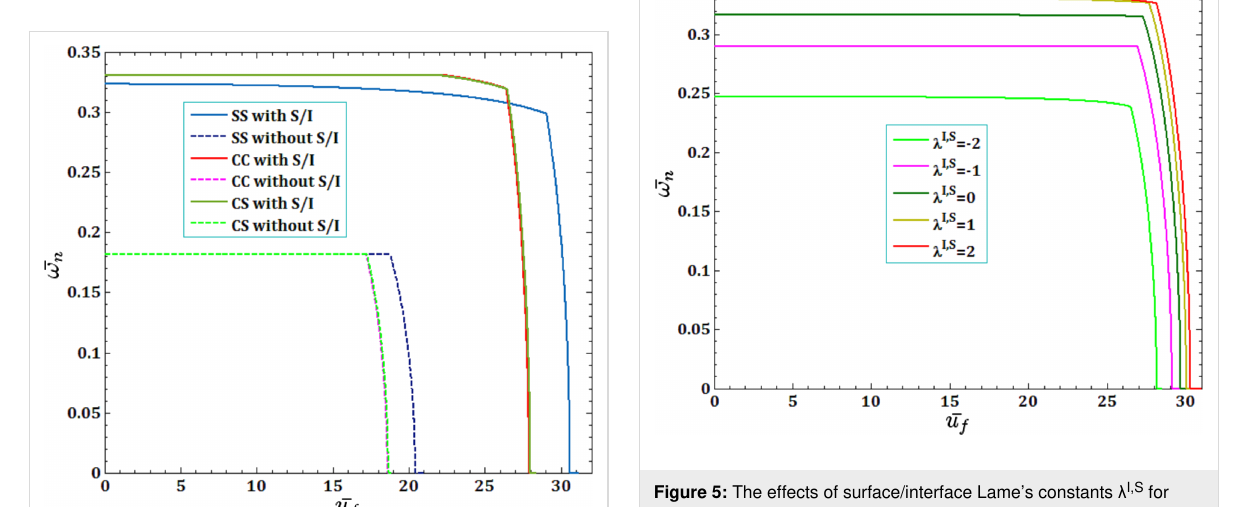
Figure 5 and Figure 6 illustrate the effects of different surface